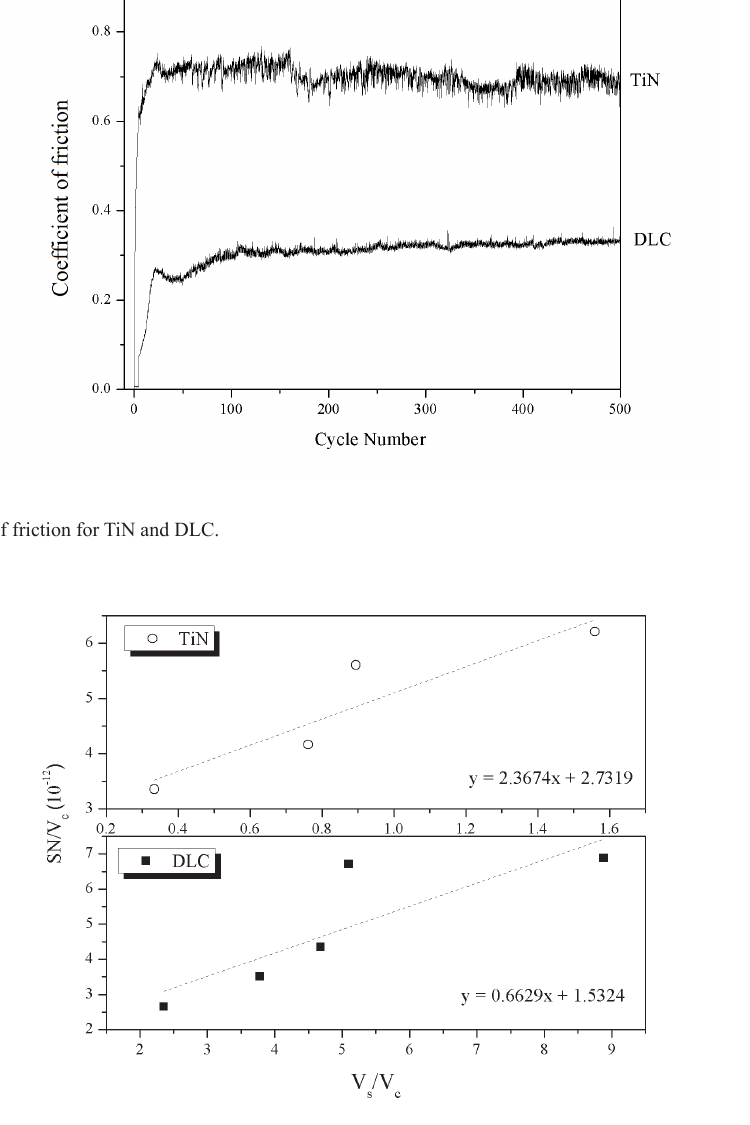
Figure 9. Plots of abrasion wear data obtained for TiN-coated M2 steel and DLC. is greater or less than k . An advantage is its potential accuracy s since the value of S.N is generally much more accurate than the volumes calculated from the measured wear scar dimensions. Separate wear scars were formed after varying numbers of ball rotations and have been measured by optical microscopy. For each scar at least five measurements of a and b were made parallel and perpendicular to the abrasion direction to obtain mean values of a and b. diameters for TiN and DLC were both measured as shown in Figure 10 and plotted against SN. There is a steady increase tendency in the size of internal and external TiN diameters, differently, a non-steady increase is observed for